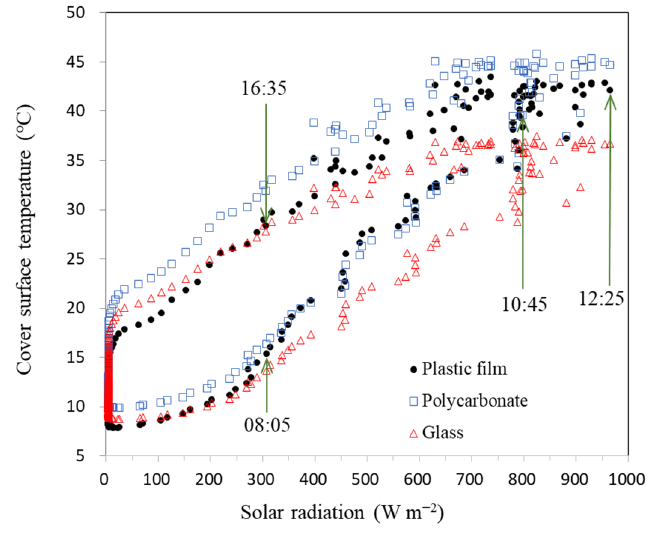
Figure 8. Comparison of inner cover surface temperatures as a function of solar radiation in greenhouses covered with different covering materials (12 − 13, 19 − 20, and 26 − 27 October 2019). houses covered with different covering materials (12–13, 19–20, and 26–27 October